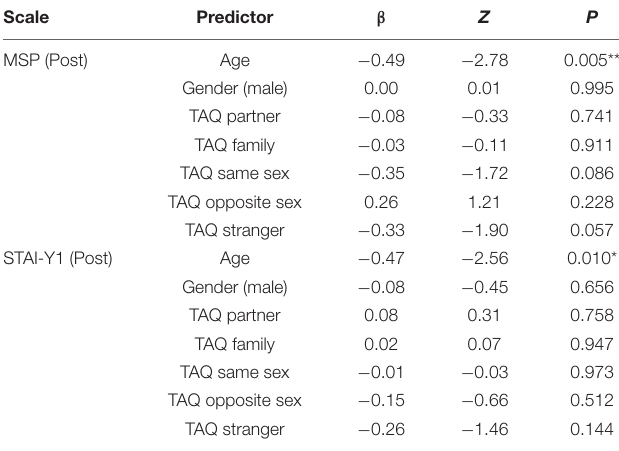
TABLE 2 | Path analysis predicting MSP and STAI-Y1